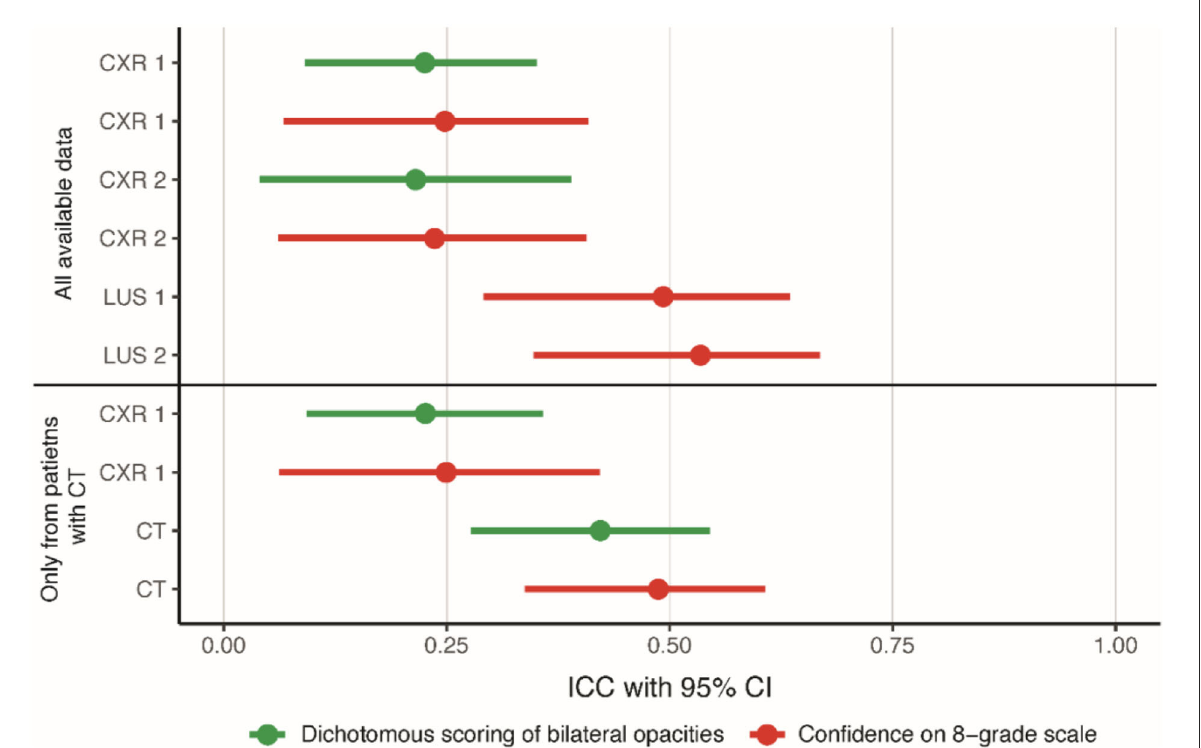
FIGURE3 Agreement on scoring ARDS for all imaging modalities. ICCs with a 95% confidence interval displaying the agreement for dichotomous scoring of bilateral opacities to diagnose ARDS and for scoring of confidence for ARDS diagnosis on an 8-grade scale. The confidence on the 8-grade scale corresponds to the confidence of the ARDS diagnosis, ranging from high confidence no ARDS (grade 1) to high confidence ARDS on both extremes (grade 8), see Figure 1A. CXR, chest x-ray; ICC, intra class correlation coefficient; LUS, lung ultrasound.